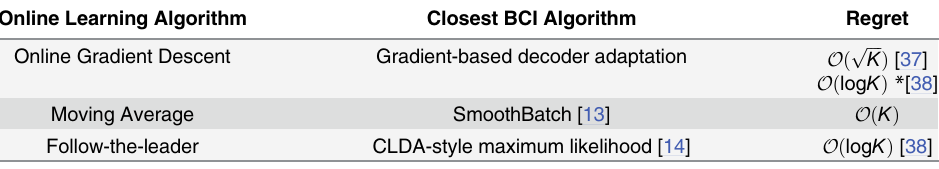
Table 1. Summary of regret for selected algorithms. Online Learning